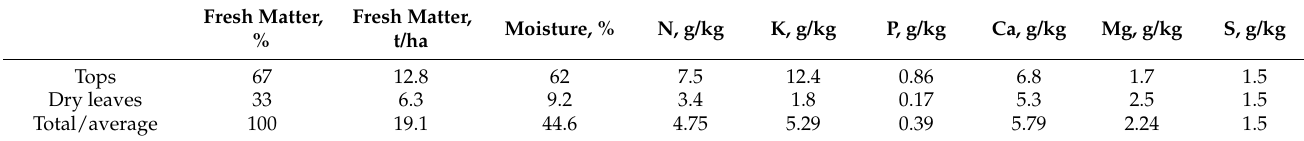
Table 5. Trash produced per hectare and its nutrient content.